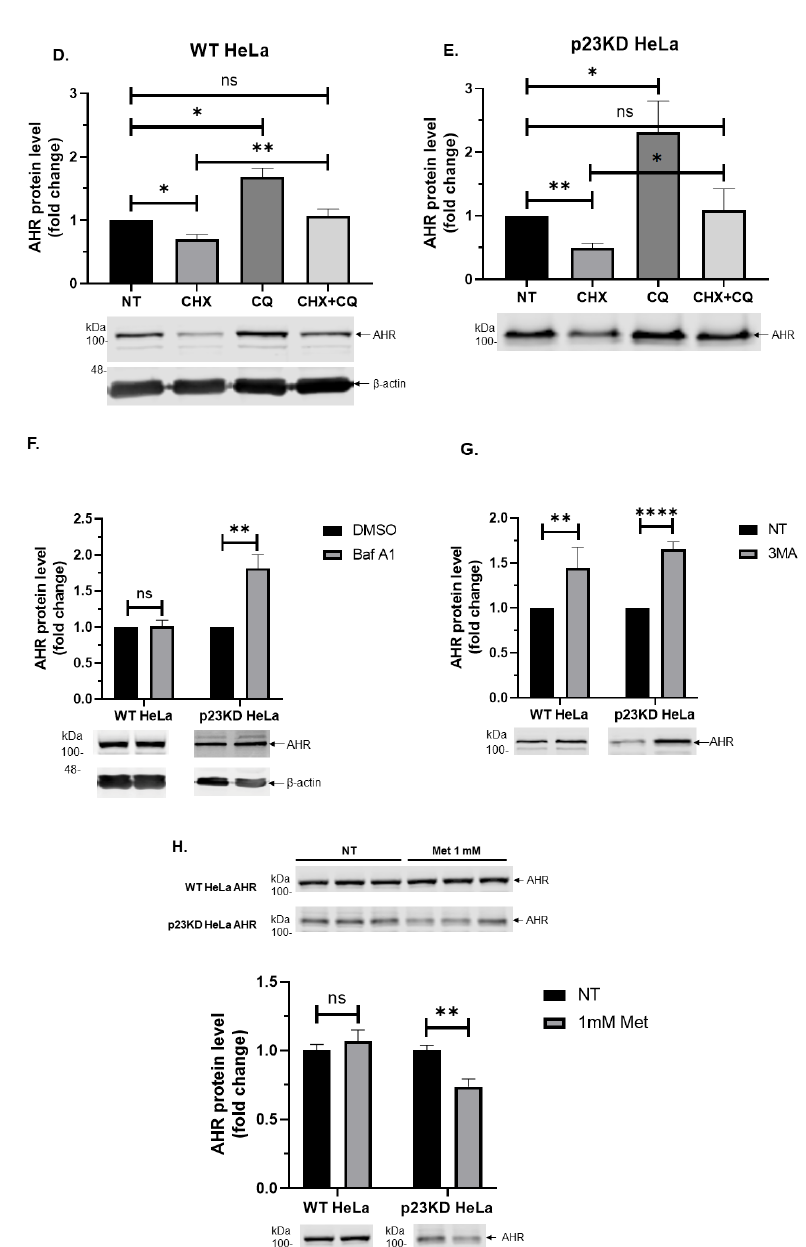
Figure 1. Using an autophagy inhibitor or activator to reveal that the aryl hydrocarbon receptor (AHR) Figure 1. Cont. ( D ) WT and ( E ) p23KD HeLa cells were treated with 40 μ g/mL of cycloheximide (CHX) undergoes autophagy in wild type (WT) and p23 stable knockdown (p23KD) HeLa cells. ( A ) MG132 for 6 h in the presence or absence of 40 μ M CQ for 12 h (6 h pre-treatment and then co-treated with (10 µ M for 6 h) decreased AHR protein levels more in HeLa cells transiently transfected with p23 shRNA CHX for another 6 h). The degradation of AHR in both cell lines was inhibited by CQ. For (D,E), the (2.5 µ g for 48 h) than in WT HeLa cells. EndoFectin transfection reagent (2:1) was used. The below below images are representative of the replicate data (means ± SD, n = 3). Conditions with no addition images are representative of the replicate data (means ± SD, n = 4). Conditions with no MG132 treatment were arbitrarily set as one (with no error bar) for data normalization. Multiple t -tests corrected with the Holm-Sidak method for multiple comparisons were performed to determine statistical significance. ( B ) WT and ( C ) p23KD HeLa cells were treated with 20 µ M or 40 µ M chloroquine (CQ) dissolved in water for 6 h. Western analysis results showed a higher increase of AHR in p23KD than in WT HeLa cells after 40 µ M CQ treatment. For ( B , C ), the below images are representative of the replicate data of one experiment (means ± SD, n = 3). Conditions with no addition as no treatment (NT) were arbitrarily set as one for comparison. This experiment was repeated once with similar results. One-way ANOVA with Sidak’s multiple comparisons test was performed to determine statistical